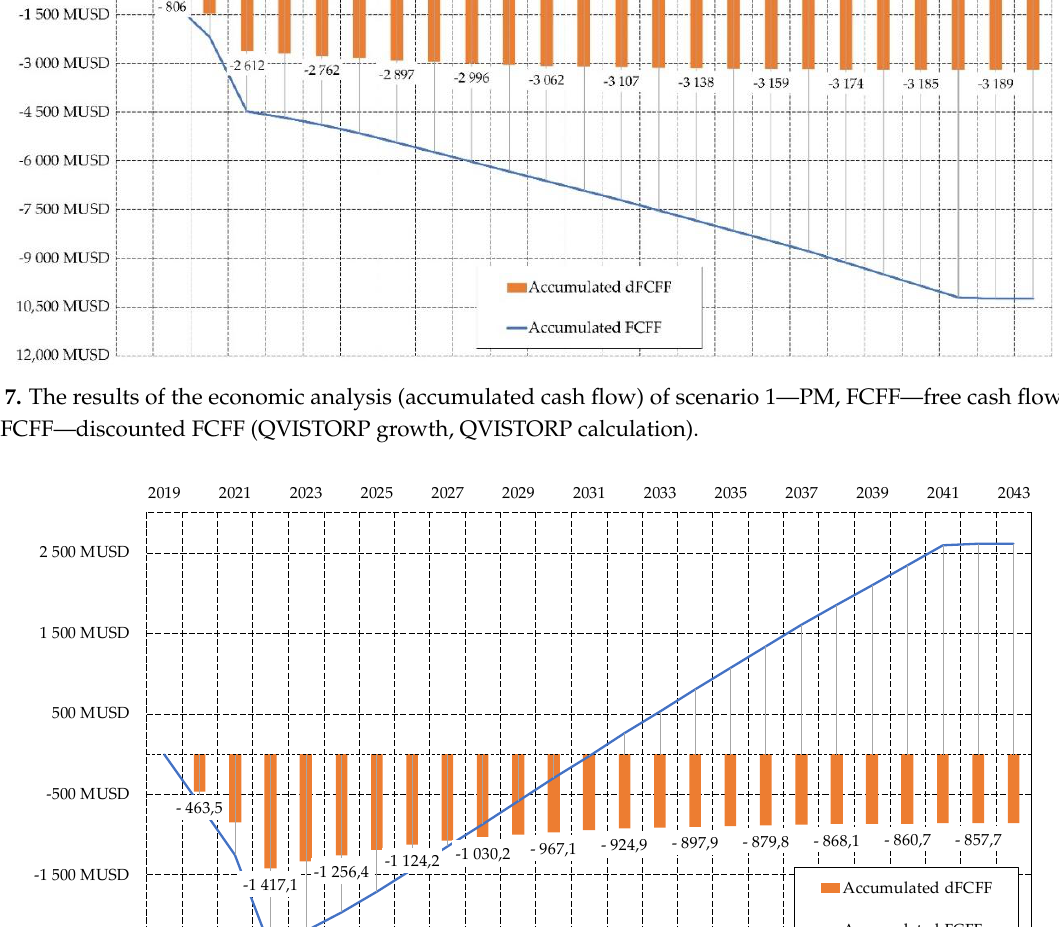
Figure 8. The results of the economic analysis (accumulated cash flow) of scenario 1—HPAL, FCFF—free cash flow for the firm, dFCFF—discounted FCFF (QVISTORP growth, QVISTORP calculation).